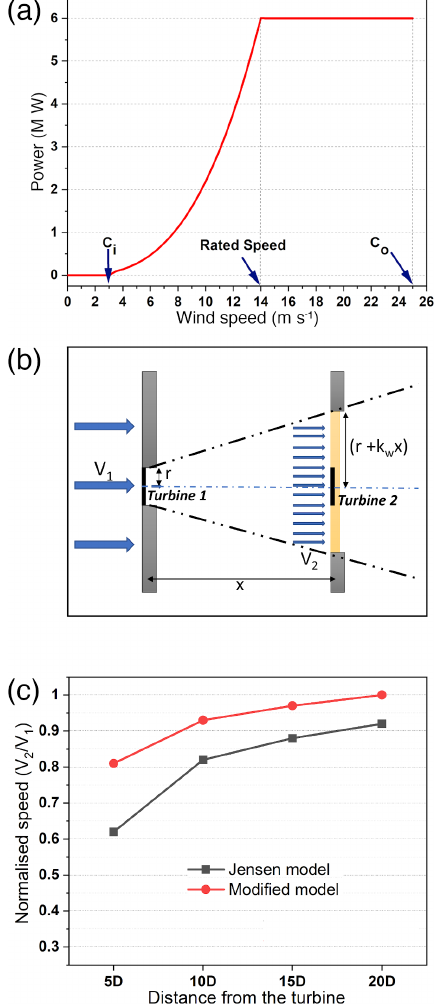
Figure 2. (a) Wind turbine power curve used in this study. (b) Jensen model schematic. (c) Wake recovery as a function of the distance from the upwind turbine for the Jensen model and the modified Jensen model used in this